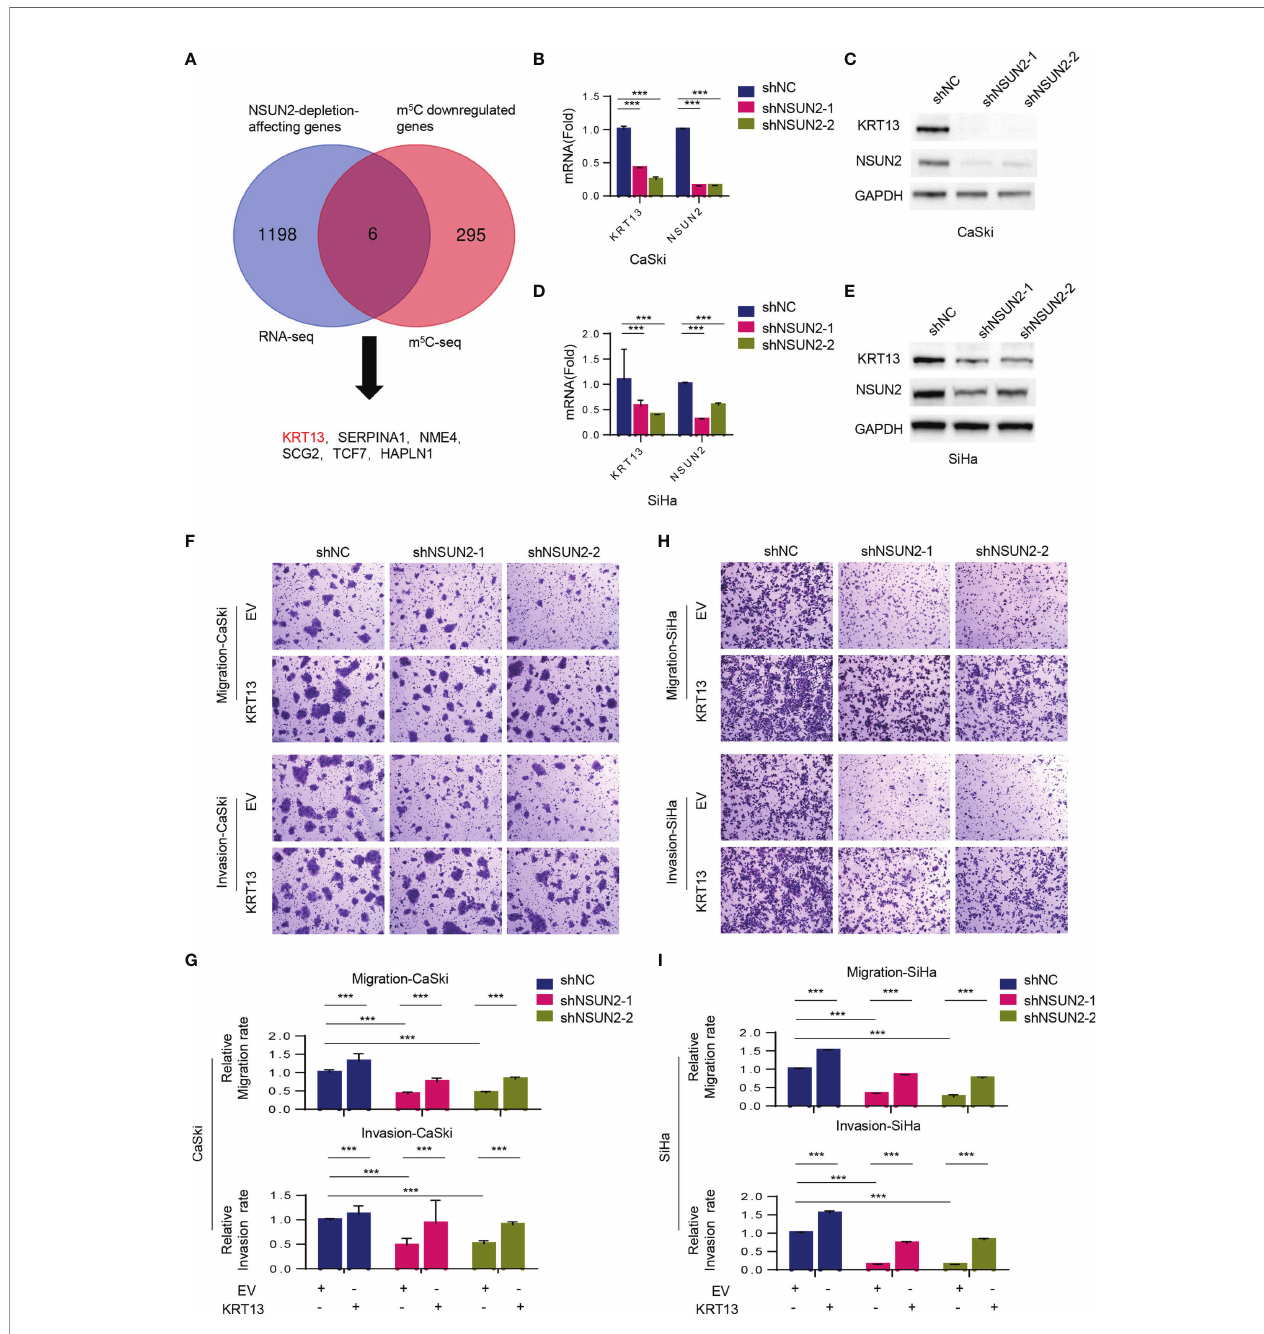
FIGURE 4 | NSUN2 promotes cell migration and invasion in cervical cancer via KRT13. (A) Venn diagram showing 6 overlapping genes between RNA-BisSeq and RNA-Seq data. (B – E) RT-qPCR and Western blot showing KRT13 mRNA and protein level in NSUN2-knockdown CaSki (B, C) and SiHa cells (D, E) . (F, G) Effect of KRT13 overexpression on cell migration (upper panel) and invasion (lower panel) in NSUN2 knockdown CaSki cells. Representative images (F) and quanti fi cation (G) of transwell assays showed the migration and invasion capability of CaSki. (H, I) Effect of KRT13 overexpression on cell migration (upper panel) and invasion (lower panel) in NSUN2 knockdown SiHa cells. Representative images (H) and quanti fi cation (I) of transwell assays showed the migration and invasion capability of SiHa. (EV, empty vector; data shown are mean ± SEM, n = 3, Student ’ s unpaired t -test for statistical analysis, *** p <